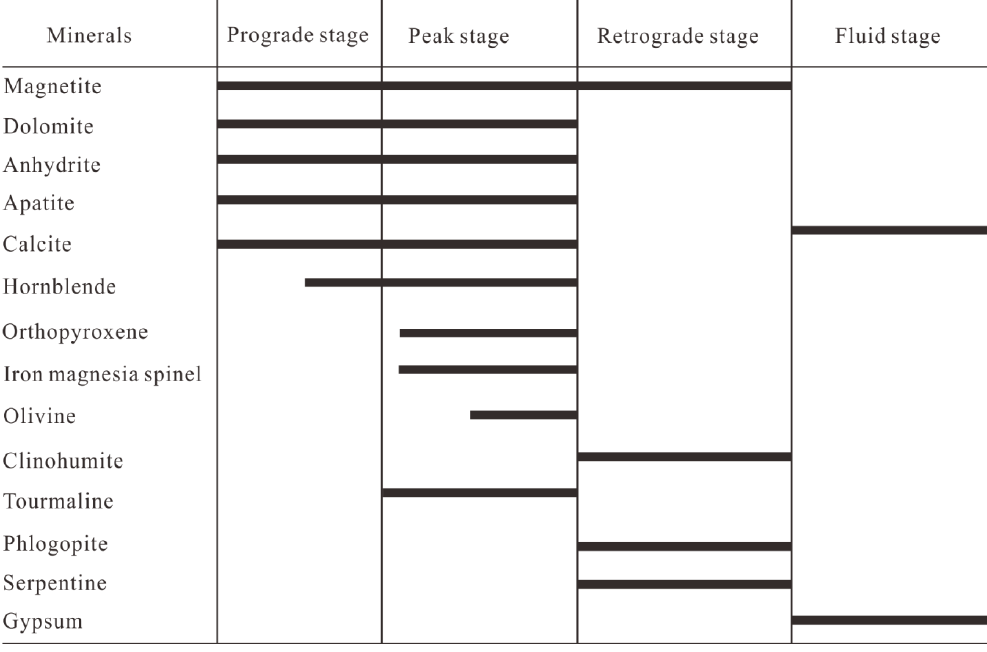
Figure 6. Paragenetic sequence of the minerals in the Zhaoanzhuang iron deposits in different metamorphic stages. metamorphic